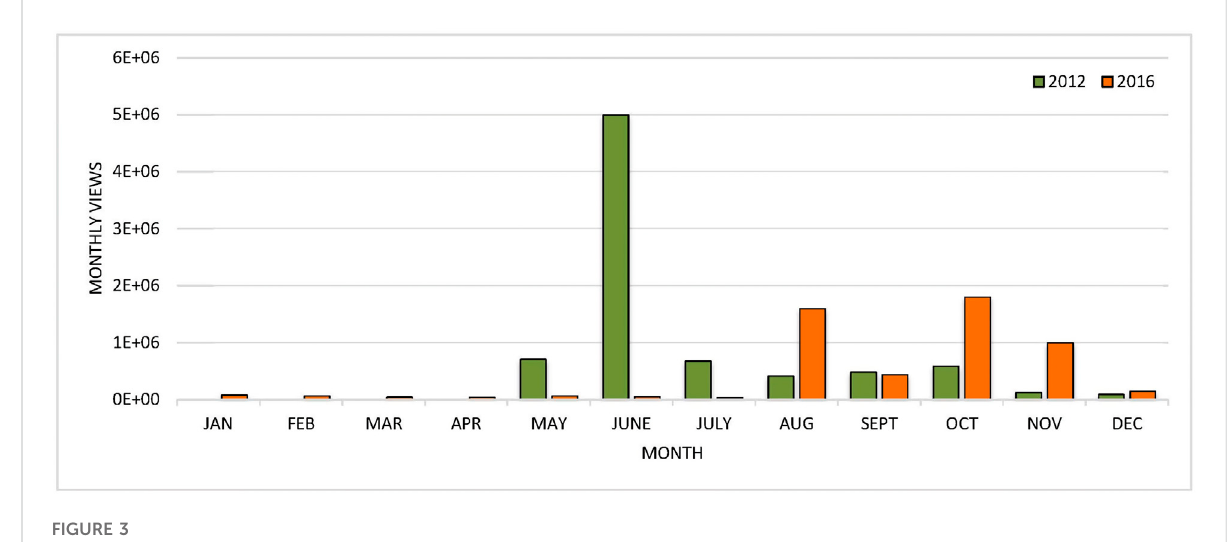
Number of the INGVterremoti blog monthly views in 2012 and